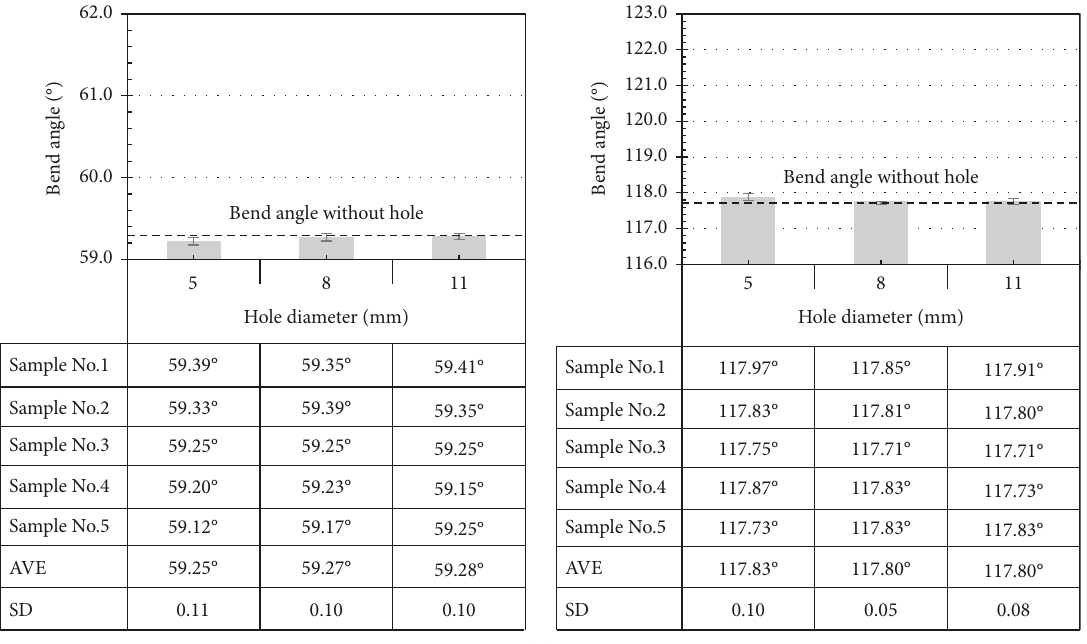
Figure 8: Effect of hole diameter on spring-back characteristic at center. (a) Hole at center. (b) Hole next to center. (c) Hole at